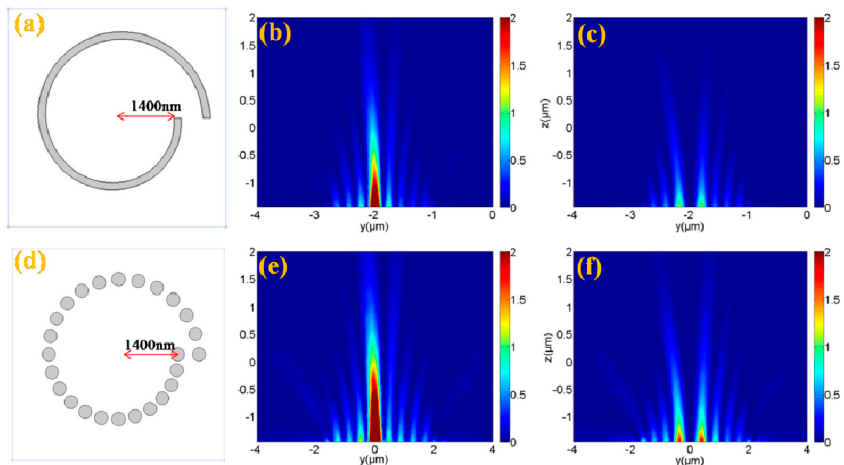
Figure 18. The longitudinal electric field intensity distributions at the yoz plane under circular polarization illuminations. ( a – c ) for the single-turn Archimedean spiral slit; ( d – f ) for the 25 Archimedean nano-pinhole array with r 0 = 1400 nm. Reproduced with permission from [63]. Copyright Optical Society of America, 2015.